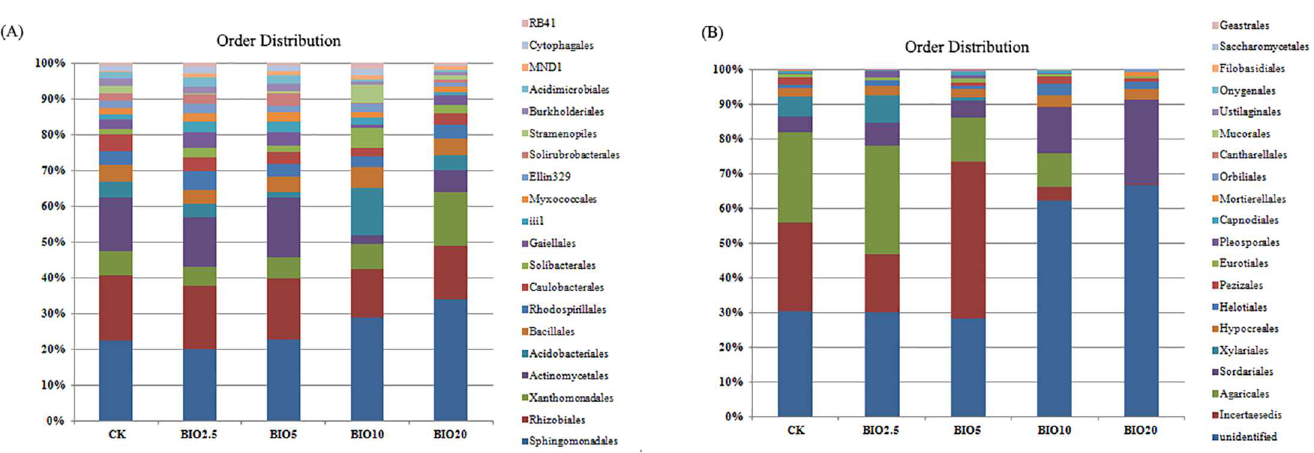
Fig 7. The relative abundances of the dominant bacterial (A) and fungal (B) orders in the five